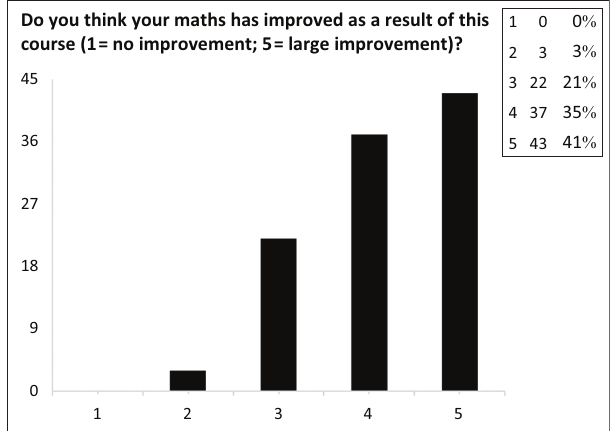
FIGURE 6: Effects of course on maths competence.